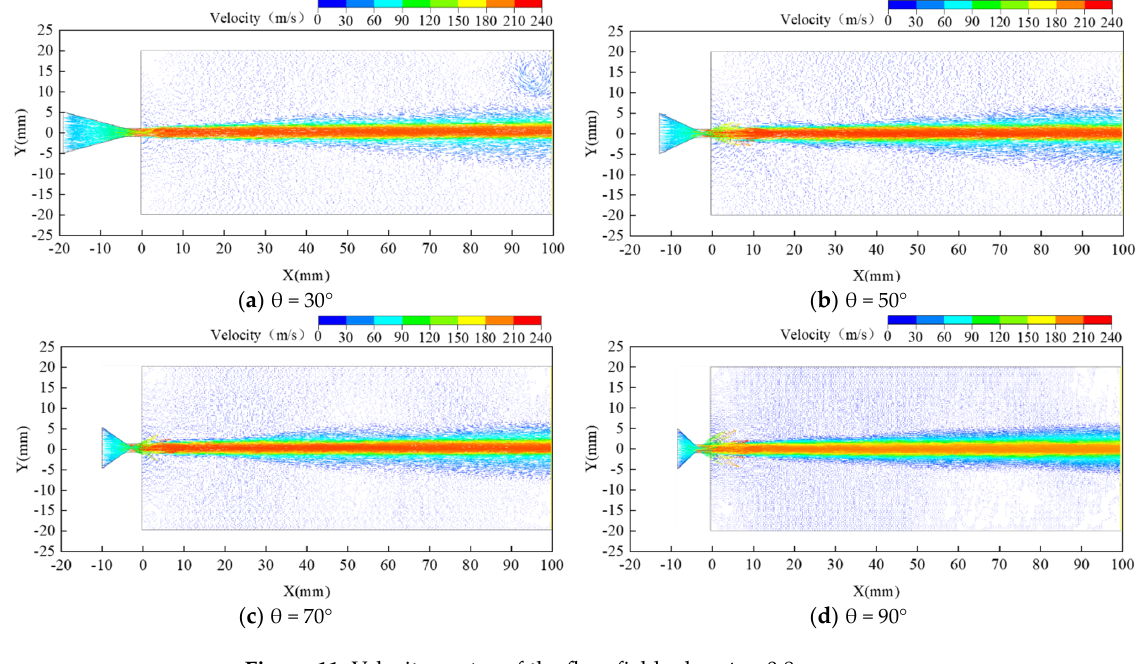
Figure 10. Velocity vector of the flow field when